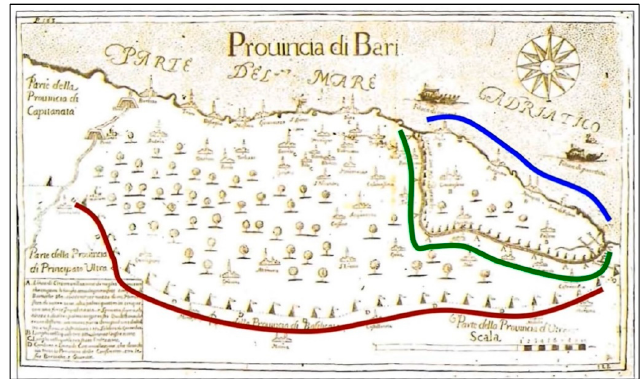
Figure 3. The first spatial health map of the plague disease in Bari, Italy, 1694. (Source: [1]).